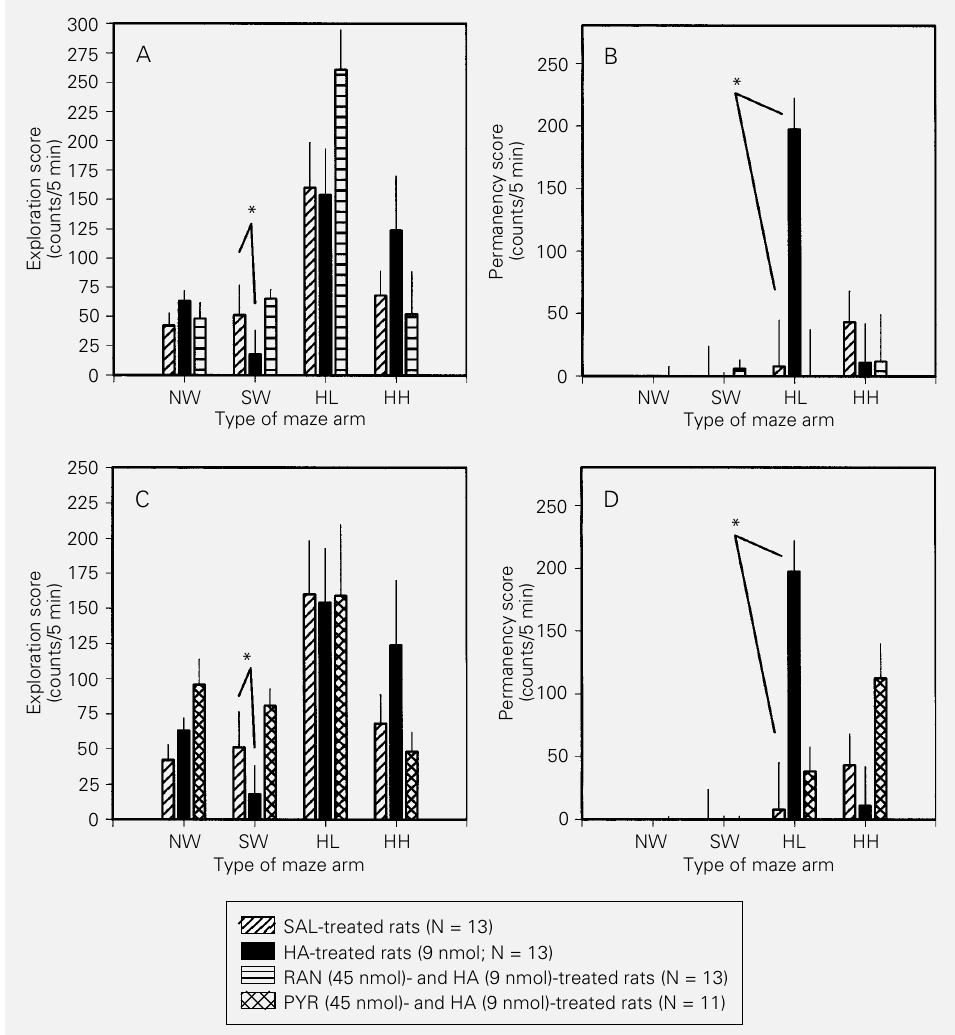
Figure 4 - Exploration (A,C) and permanency (B,D) scores in the asymmetric plus-maze of im- planted rats treated with saline (SAL), histamine and histamine antagonists. *P<0.05, HA- treated rats vs SAL-treated rats (nonparametric Dunn test) . Sa- line- and histamine-treated groups, described in Figures 2 and 3, have been included in or- der to facilitate comparisons. RAN = Ranitidine; PYR = pyril- amine; HA = histamine. See Fig- ure 1 for explanation of abbre-